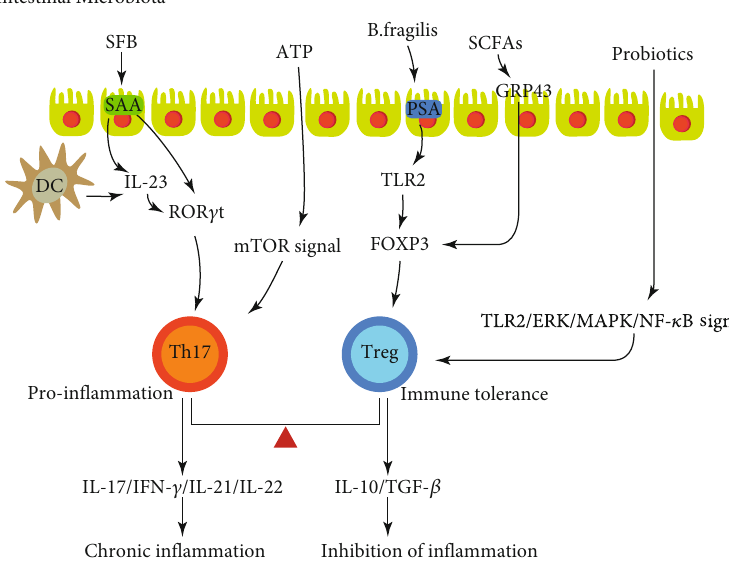
Figure 2: The role of intestinal microbiota in Th17/Treg